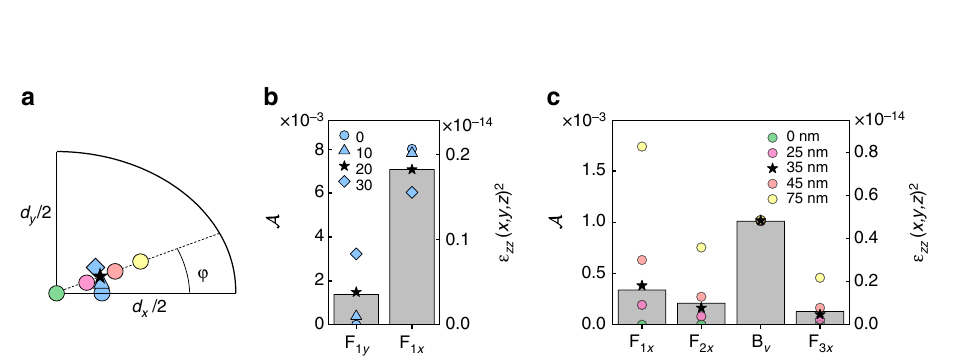
0.0 Fig. 4 Determination of the QD position inside the nanowire. a One quadrant of the QD plane ( x and y correspond to the long and short axis of the ellipse, respectively). Coloured symbols correspond to various QD positions which result in the spectral signatures in b and c . The black star corresponds to the position of QD1. b Grey bars , left axis : experimental data obtained in protocol 1. Symbols, right axis : simulated strain along the z axis for four different angles (in degrees) and a fi xed distance ( r = 35 nm) to the centre (a different distance results in a linear scaling of the right axis). c Comparison between experiment (protocol 2) and simulated strain along the z axis for various QD distances to the centre ( ϕ =